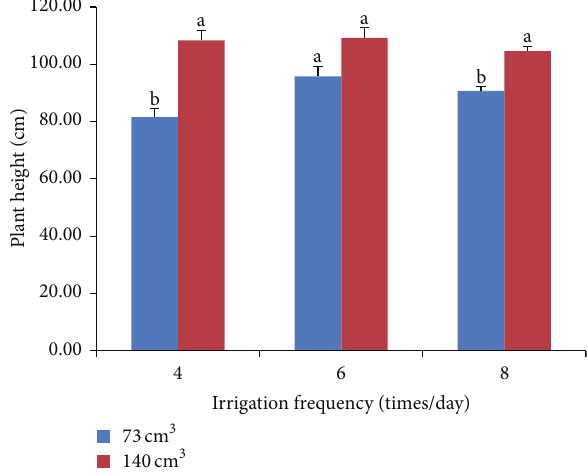
Figure 1: Interaction effects of irrigation frequencies and substrate volumes on plant height of